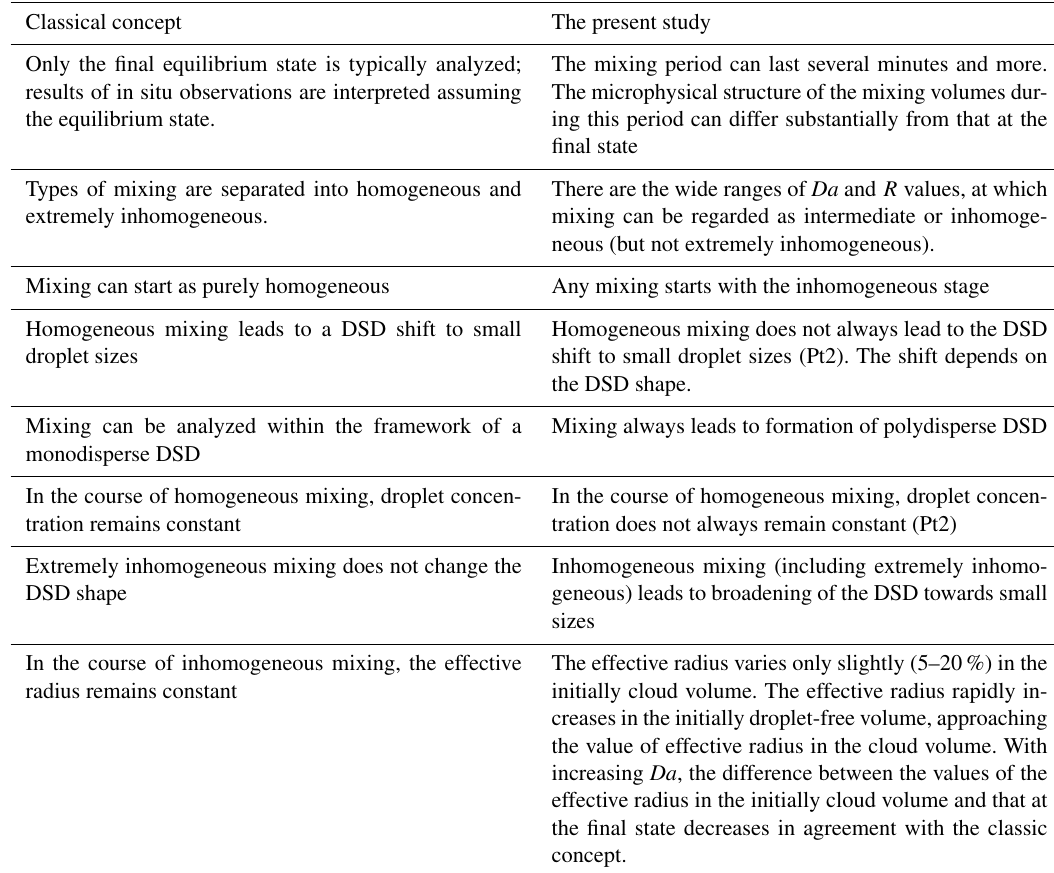
Table 2. Comparison of analysis based on the classic concepts of mixing and the results of the present study. Classical